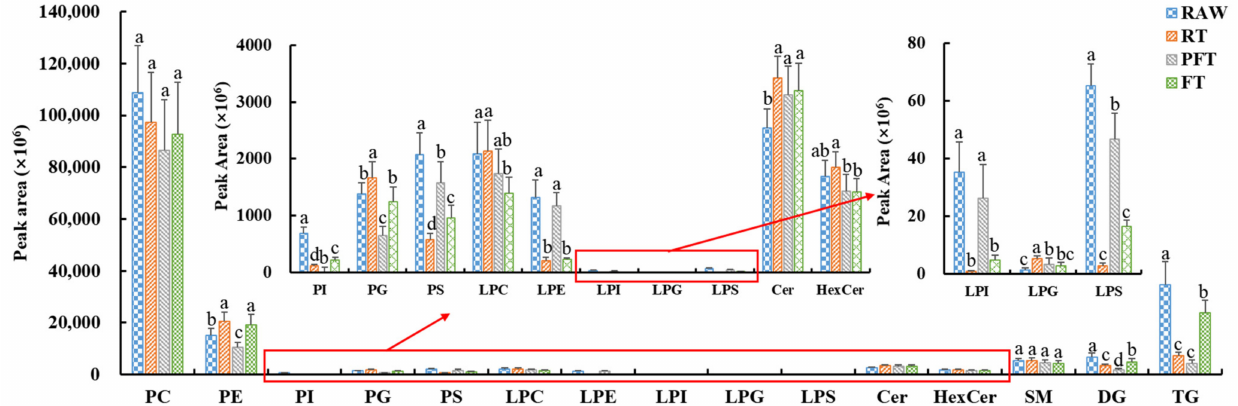
Figure 2. Analysis of peak areas of lipid species in L. vannamei after low-temperature storage (values with different letters are significantly different ( p < 0.05)). Note: RAW: fresh group; RT: refrigerated treatment (4 ◦ C); PFT: particle-freezing treatment ( − 2 ◦ C); FT: frozen treatment ( − 18 ◦ C); PC: phosphatidylcholine; PE: phosphatidylethanolamine; PI: phosphatidylinositol; PG: phosphatidylglycerol; PS: phosphatidylserine; LPC: lysophosphatidylcholine; LPE: